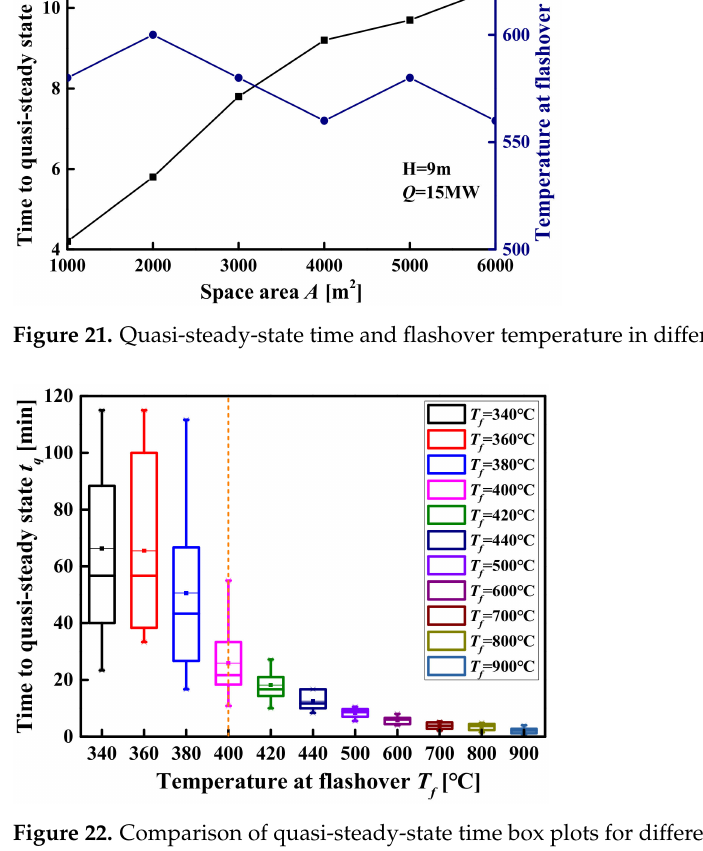
Figure 22. Comparison of quasi-steady-state time box plots for different flashover